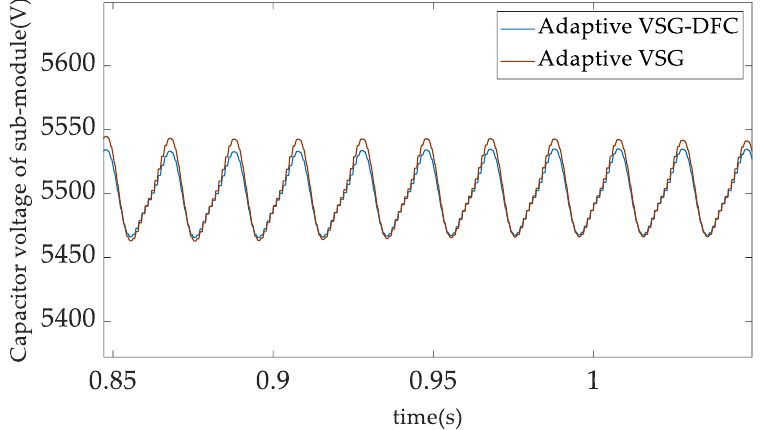
Figure 21. Capacitor voltage of submodule under two controls.